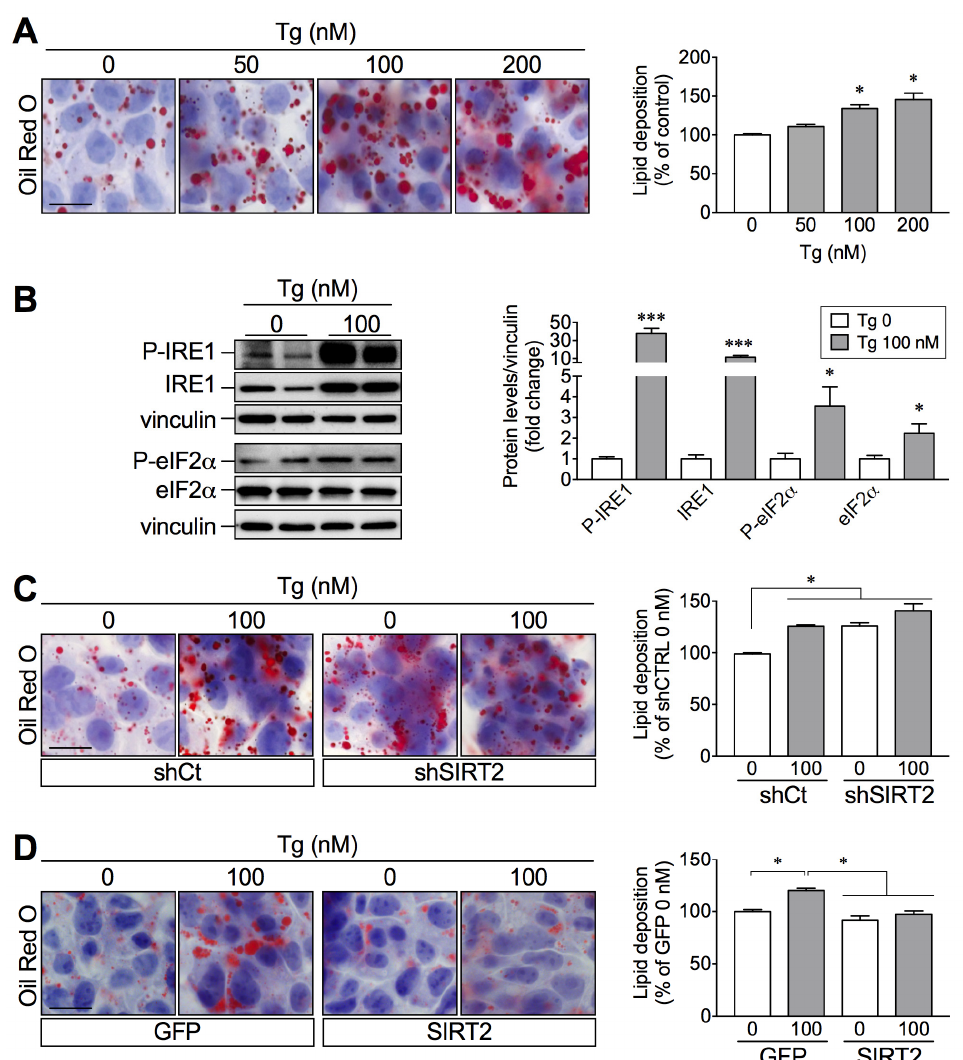
Figure 5. Thapsigargin-induced lipid accumulation is prevented by SIRT2 overexpression. ( A ) Representative images of ORO-stained HepG2 cells incubated with increasing thapsigargin (Tg) concentrations (0, 50, 100, 200 nM) for 24 h and spectrophotometric quantification of intracellular lipids. ( B ) Representative Western blots of P-IRE1 (Ser724), IRE1, P-eIF2 α (Ser51), and total eIF2 α of HepG2 cells treated with vehicle or Tg (100 nM) for 24 h. All target protein levels were normalized to the levels of the housekeeping protein in the same lane. Values in the graph were normalized for the vehicle control (0 Tg). ( C , D ) Representative images and spectrophotometric quantification of intracellular lipids of ORO-stained HepG2 cells infected with lentiviruses expressing either a short hairpin for control (shCTRL) and SIRT2 (shSIRT2) to silence SIRT2, as well as a vector with GFP sequence (GFP) and SIRT2 sequence (SIRT2) for the overexpression. These cells were treated as in B (scale bar = 50 µ m). Results are presented as mean SEM; n = 3 per group; * p < 0.05, *** p <